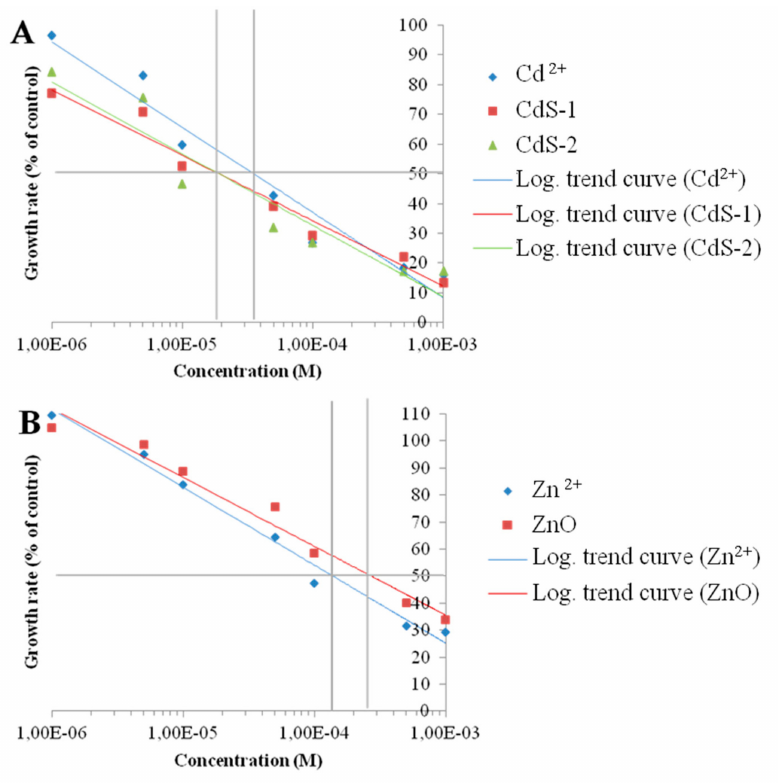
Figure 4. IC 50 logarithmic trend curves as a function of growth rate. ( A ) Zn 2 + and ZnO and ( B ) Cd 2 + , CdS-1, and CdS-2 are expressed as % of control. Growth rate was determined between the third and the fourth